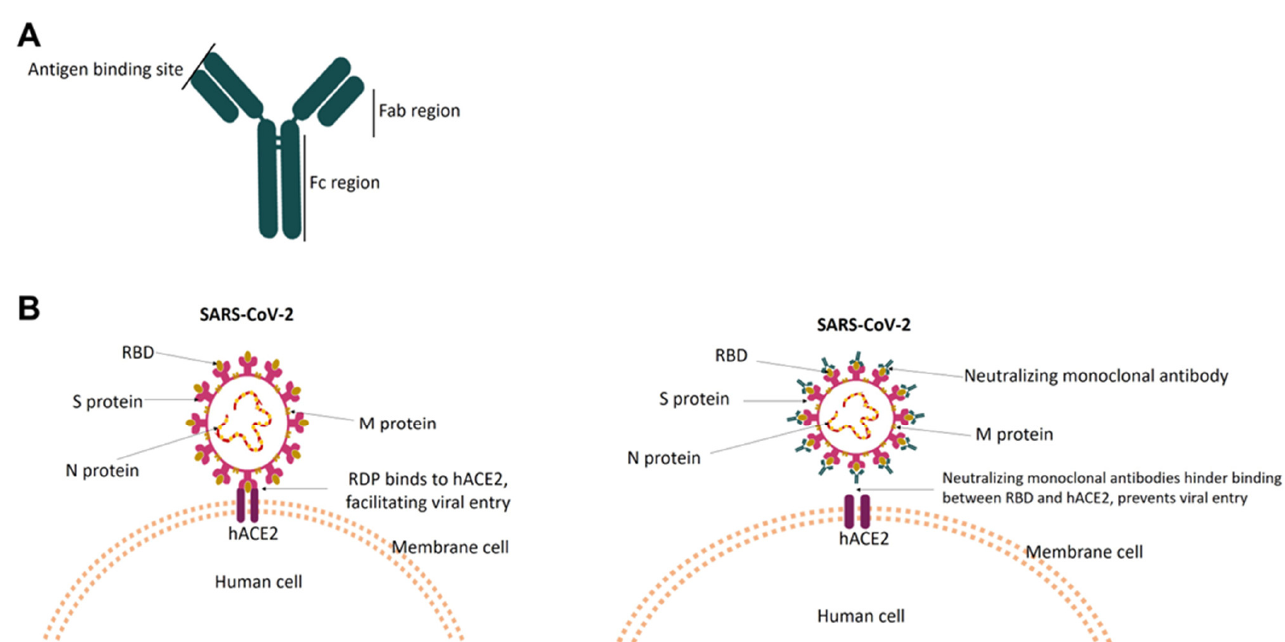
Figure 2. Diagram representing the structure of the monoclonal antibody, and the neutralizing mechanism. In ( A ), the monoclonal antibody is comprised of chains that are connected by disulfide linkage to form a “Y” shape. The region that binds to the target antigen is indicated. In ( B ), the RBD binds to hACE, which facilitates viral entry into the cells ( left ). Monoclonal antibodies disrupt the RBD–hACE interaction by targeting the RBD (antigen), thus hindering viral entry into the cells ( right ).